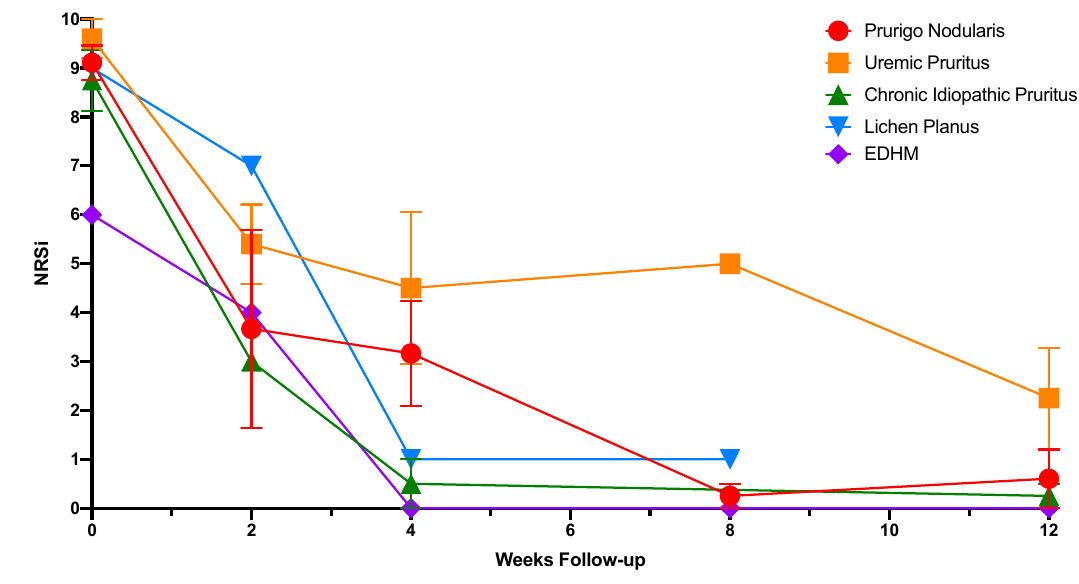
Figure 2. Response to dupilumab by disease over time.